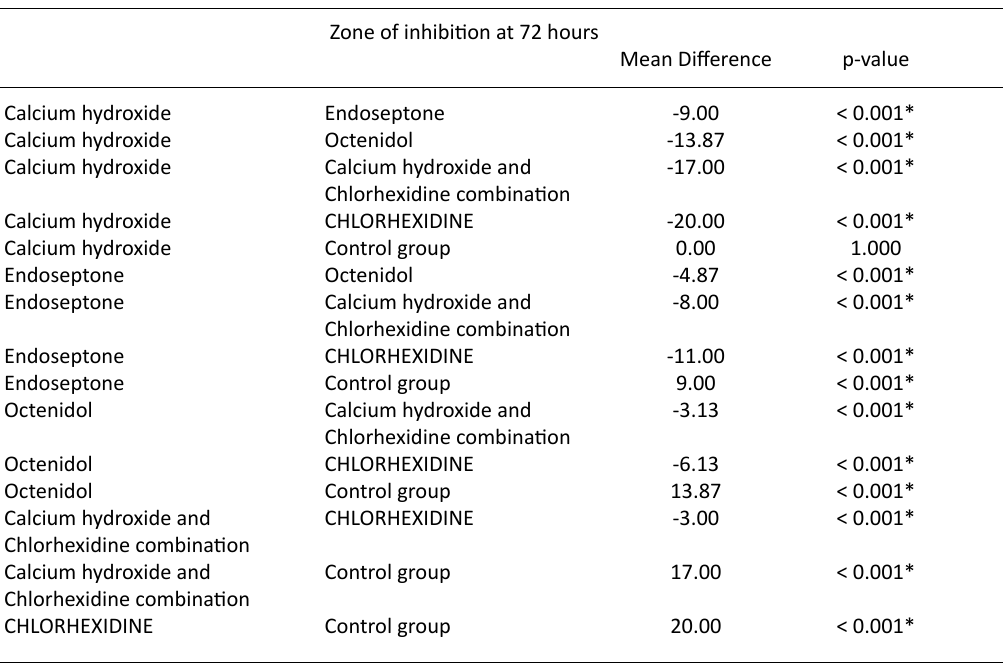
Table 4. Difference of zone of inhibition of various medicament at 72 hours Zone of inhibition at 72 hours Mean